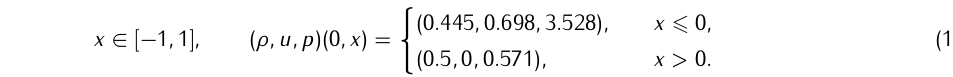
1 1 t l x -norm and l x -norm at time t = 0 . 4 with respect to the averaged number of cells, and